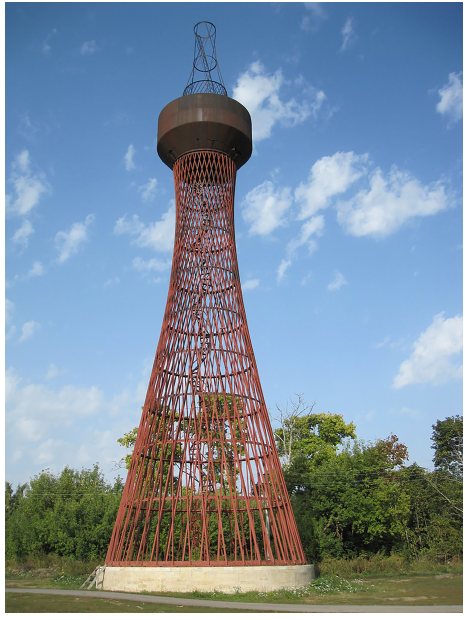
Figure 4: Water tank by V. Shukhov [42].